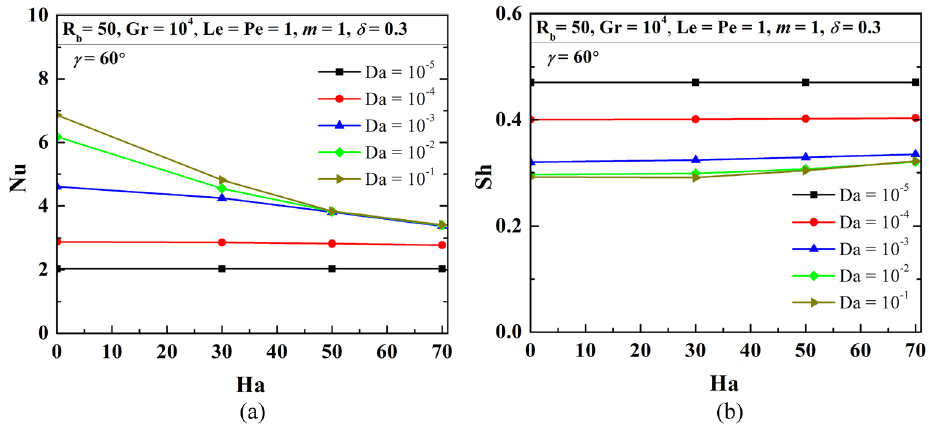
Figure 19. Variations of global Nu ( a ), and Sh ( b ) when R b = 50, Le = Pe = 1, Gr = 10 4 , m = 1, δ = 0.3, γ = 60° changing Hartmann (Ha) and Darcy (Da)